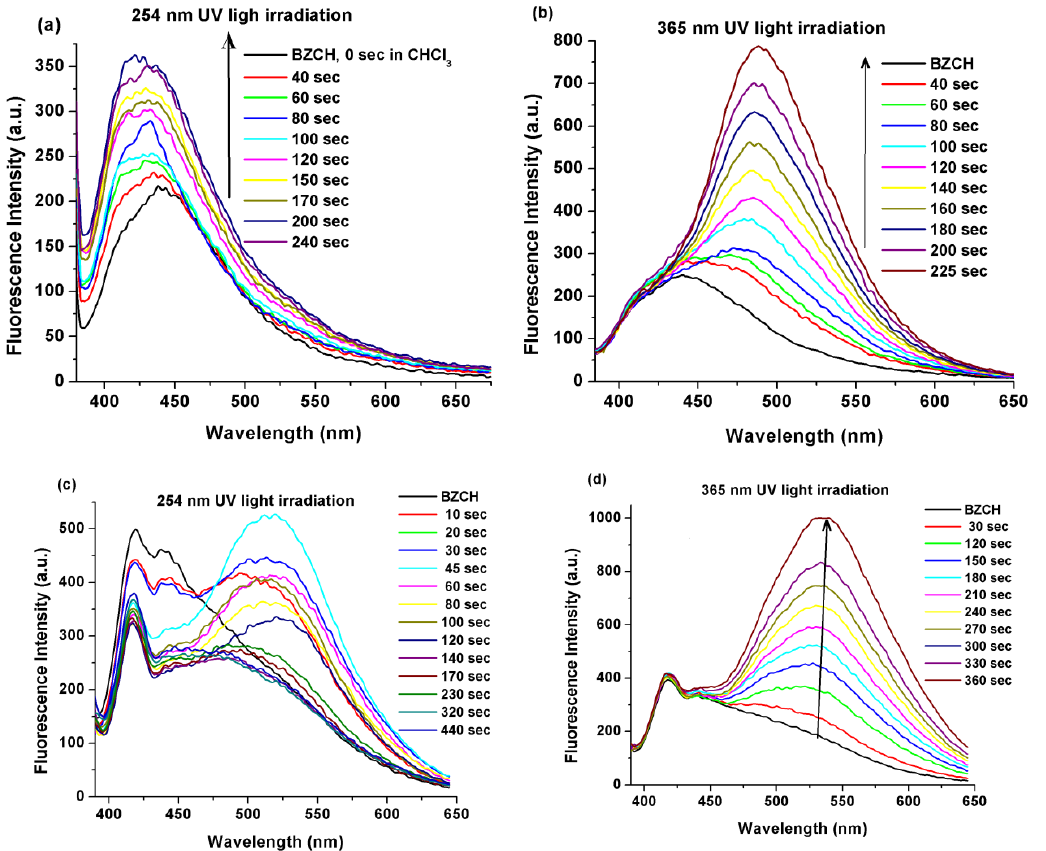
Figure 7. Changes in the fluorescence spectra of BZCH in CHCl 3 ( a , b ) and DMSO ( c , d ) solutions, upon irradiation with 254 ( a , c ) and 365 nm ( b , d ) UV light. The excitation wavelength was set at 362 nm in CHCl 3 and 370 nm in DMSO solvents.